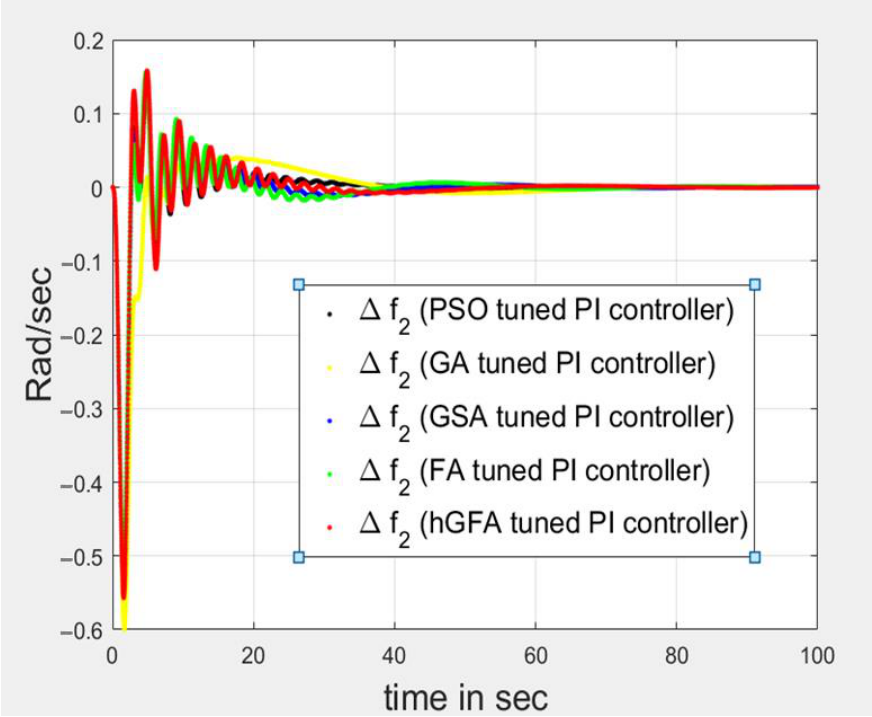
Figure 3. Perturbation in load frequency response in area-2 of HTPS for case study-I.